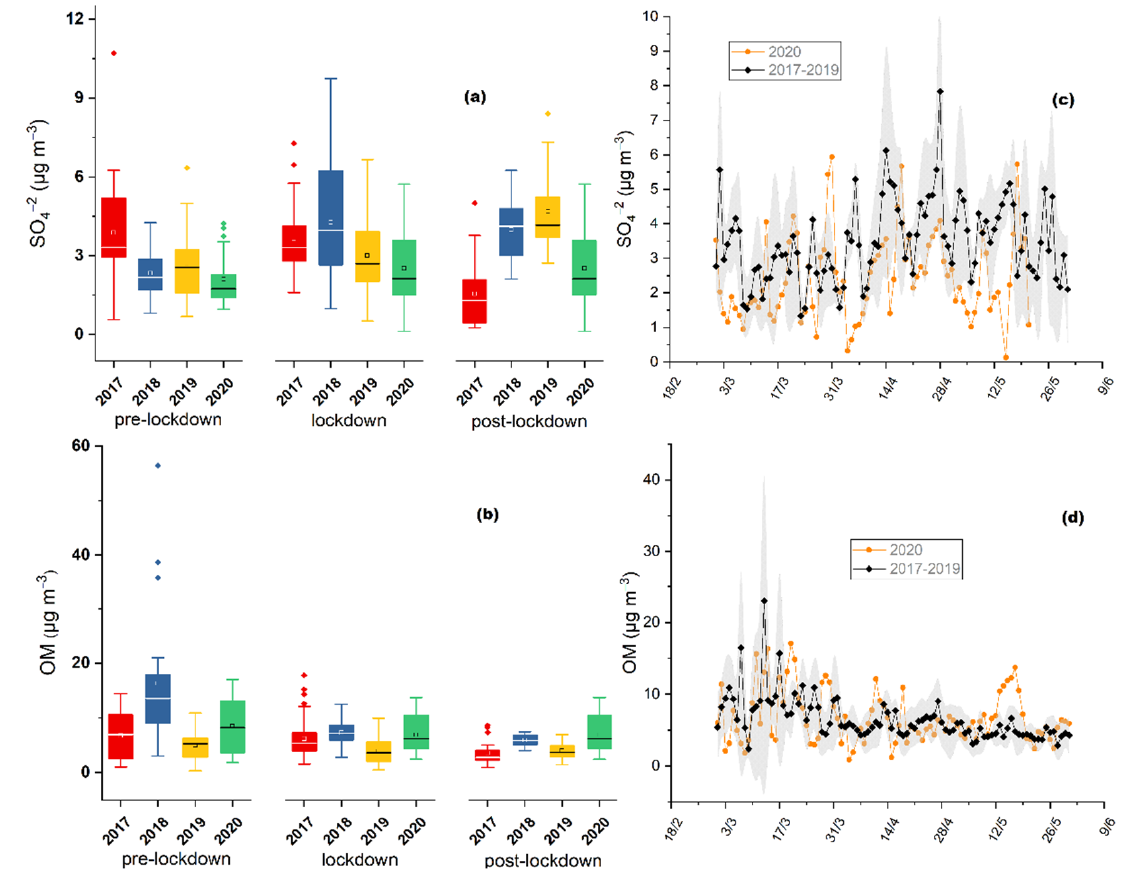
Figure 4. Average values and standard deviations of ( a ) SO 4 − 2 concentrations ( μ g m − 3 ) and ( b ) OM concentrations ( μ g m − 3 ); for pre-lockdown (1–22 March), lockdown (23 March–10 May) and post- lockdown period, from 2017 to 2020, at the Thissio site. The dots represent the outlier values; ( c ) SO 4 − 2 concentrations ( μ g m − 3 ) and ( d ) OM concentrations ( μ g m − 3 ) average of 3-year (2017–2019) daily values (standard deviations marked as grey area), compared to daily values of 2020, from 1 March to 10 May, at the Thissio site.